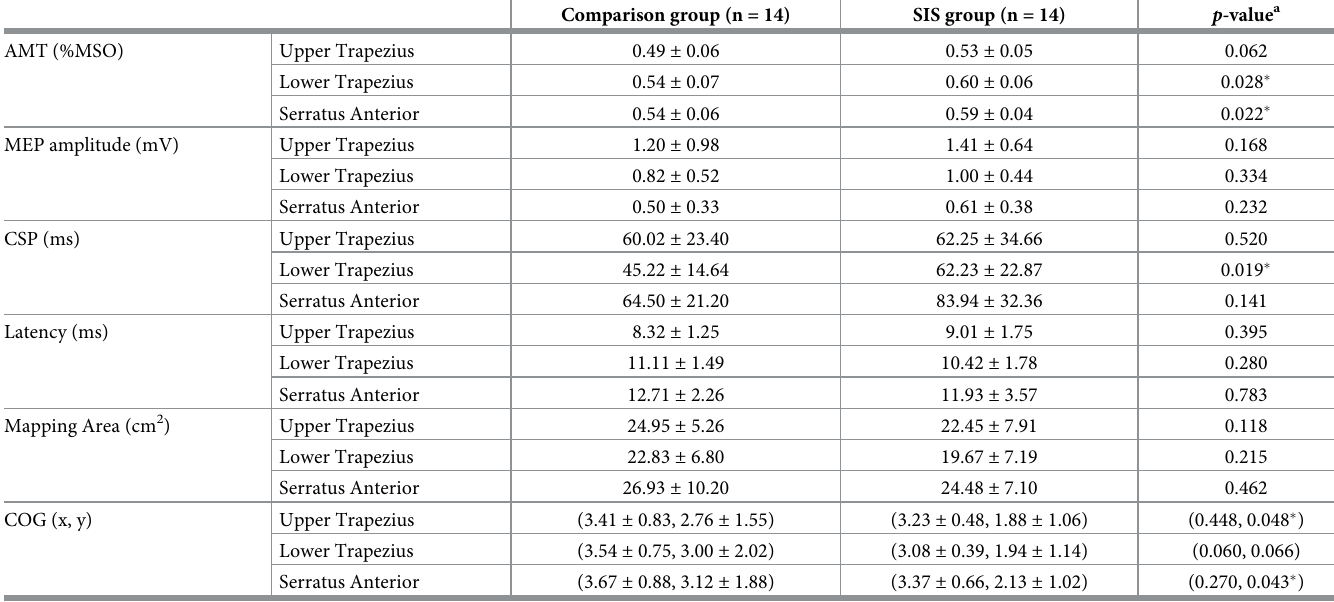
Table 2. Comparisons of corticospinal excitability between the SIS and comparison groups (mean ± SD).